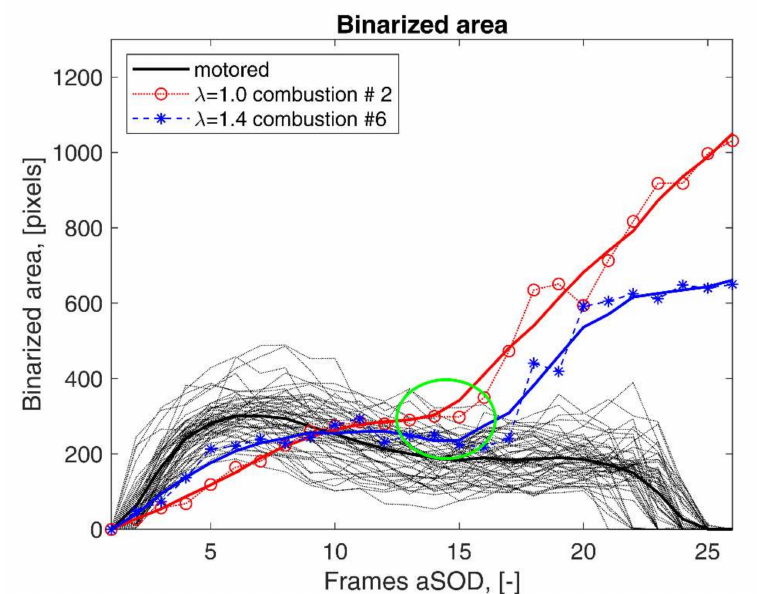
Figure 10. Binarized area during the discharge / combustion event, first quadrant. Black dotted lines refer to each discharge event in motored conditions (no combustion), and the black solid line is their average. Red and blue dashed curves with markers are, respectively, the curves corresponding to the λ = 1.0 second event and the λ = 1.4 sixth event, as examples. Finally, red and blue solid lines are the corresponding smoothed curves (five-point moving average). For both combustion cases, we would expect a visible flame kernel in the narrow range between the 13th and the 16th frame after the start of discharge (aSOD; green